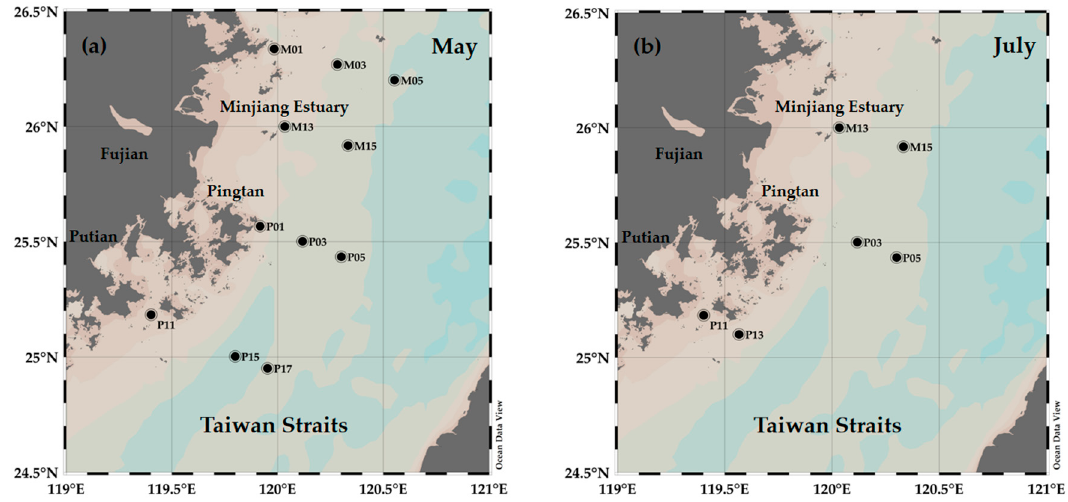
Figure 1. Sampling stations during the cruises in May ( a ) and July ( b ) 2019 in Taiwan Strait.